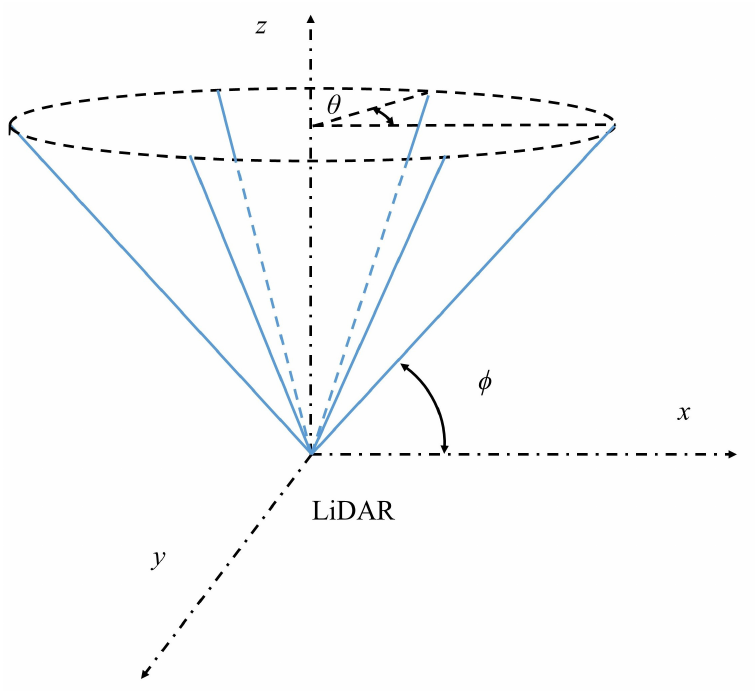
Figure A1. Schematic overview of Doppler LiDAR used to measure wind profiles. u is the wind velocity vector at the measurement point, u 0 is the reference velocity vector at the center of the circle being scanned by LiDAR, v R is the radial velocity, r is the radial distance from the LiDAR, φ is the elevation angle, and θ is the azimuthal